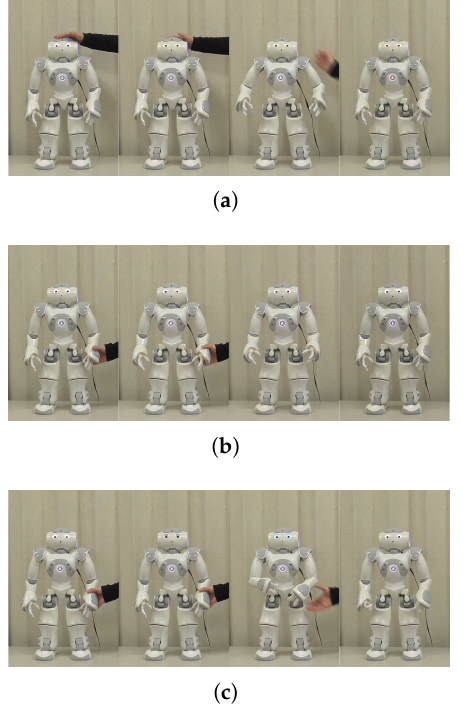
Figure 4. Frames from videos of reactions of NAO to human touch with emotions. ( a ) Reaction to “Happy” emotion; ( b ) Reaction to “Sad” emotion; ( c ) Reaction to “Angry”